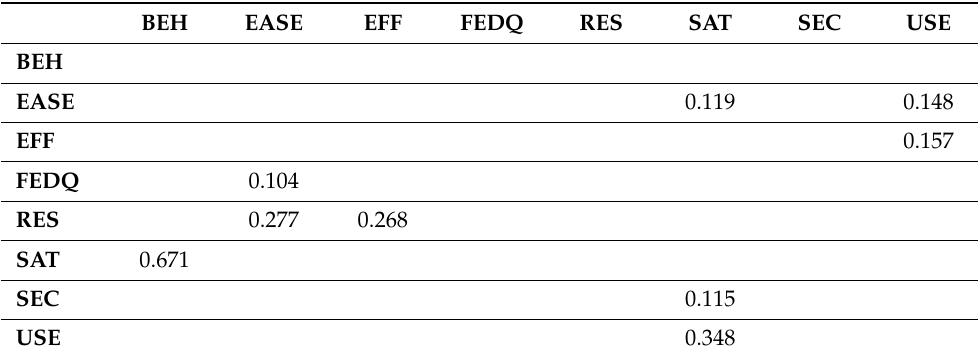
Table 8. Results of testing the effect